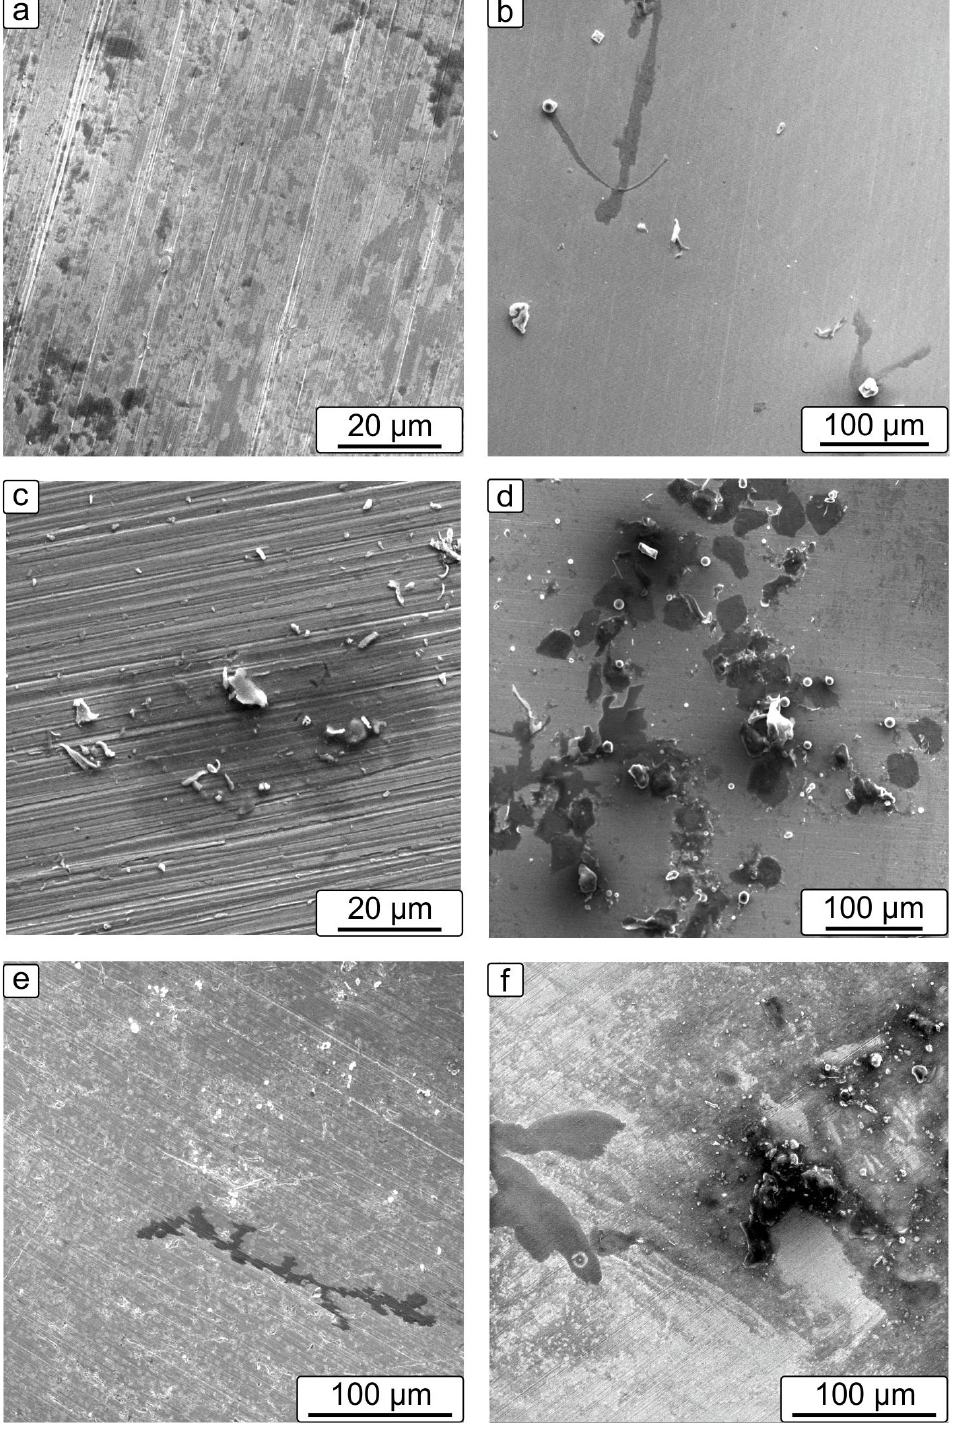
Figure 10. SEM images for SS 316L ( a , c , e ) and SS 304L ( b , d , f ) after potentiodynamic corrosion testing in loaded MEA solution.